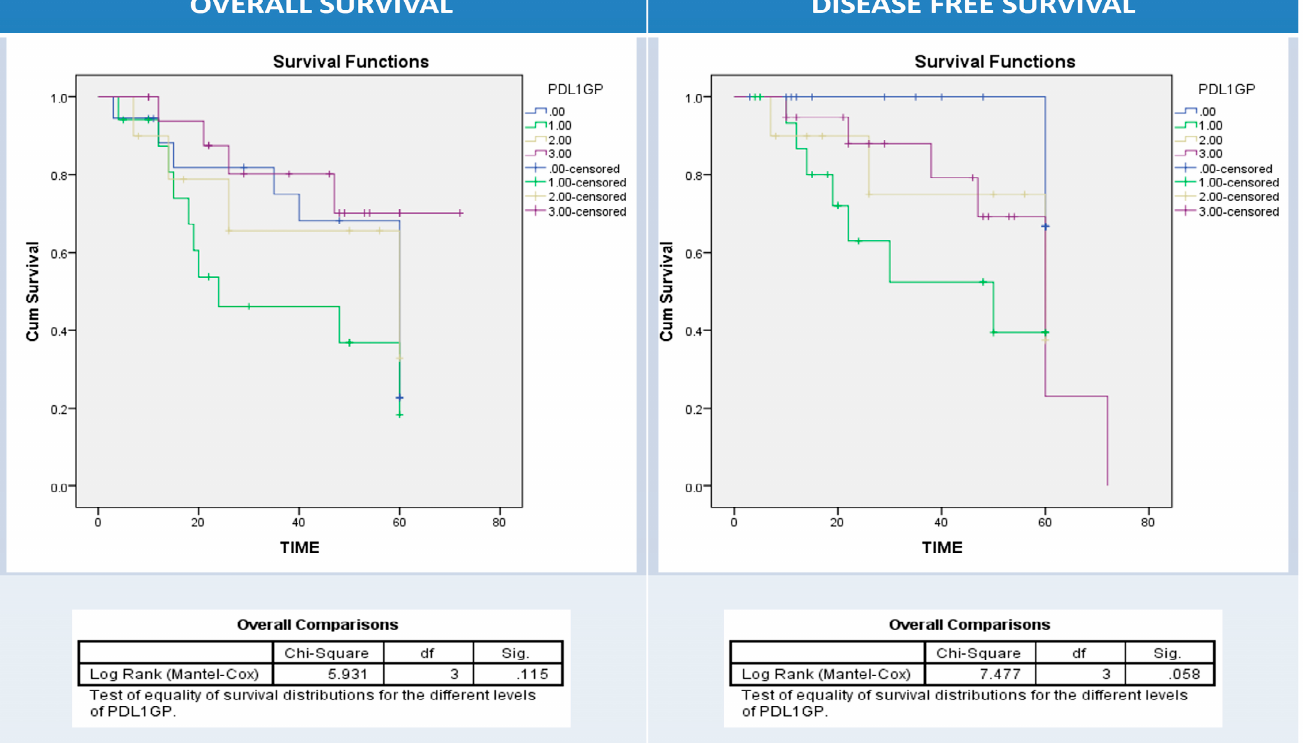
Figure 9. Kaplan–Meier survival curves for overall (right panel) and disease-free survival (left panel) according to combined PDL1 expression pattern (NC-IIC). 0: blue (NC-IIC-); 1.00: green (NC+ IIC); 2.00: yellow (NC-IIC+); 3: purple (NC+IIC+). Log Rank test (Mantel–Cox) was used. Multivariate regression analysis using all clinical and pathological variables failed to detect PDL1 (IIC) and BRAF protein expressions as independent predictors for survival and relapse. However, tumor PDL1 expression can be used as an independent predictor of OS and DFS [OS: HR, 3.250; 95% CI, 1.088–9.713; p = 0.035 and DFS: HR, 2.241; 95% CI, 1.003–5.006; p = 0.049]. PD1 overexpression in stromal IICs was independently associated with short OS (HR: 0.233, 95% CI: 0.060–0.903, p = 0.035). In addition, the right-side location of CRC revealed an independent association with short overall survival (HR: 433.167, 95% CI: 1.437-130573.1, p = 0.037) (Table 6). Table 6. Cox proportional hazard regression analysis of overall and disease-free survival among patients with colon adenocarcinomas. OS DFS 95.0% CI for Exp(B) 95.0% CI for Exp(B) Sig. Exp(B) Sig. Exp(B) Lower Upper Lower